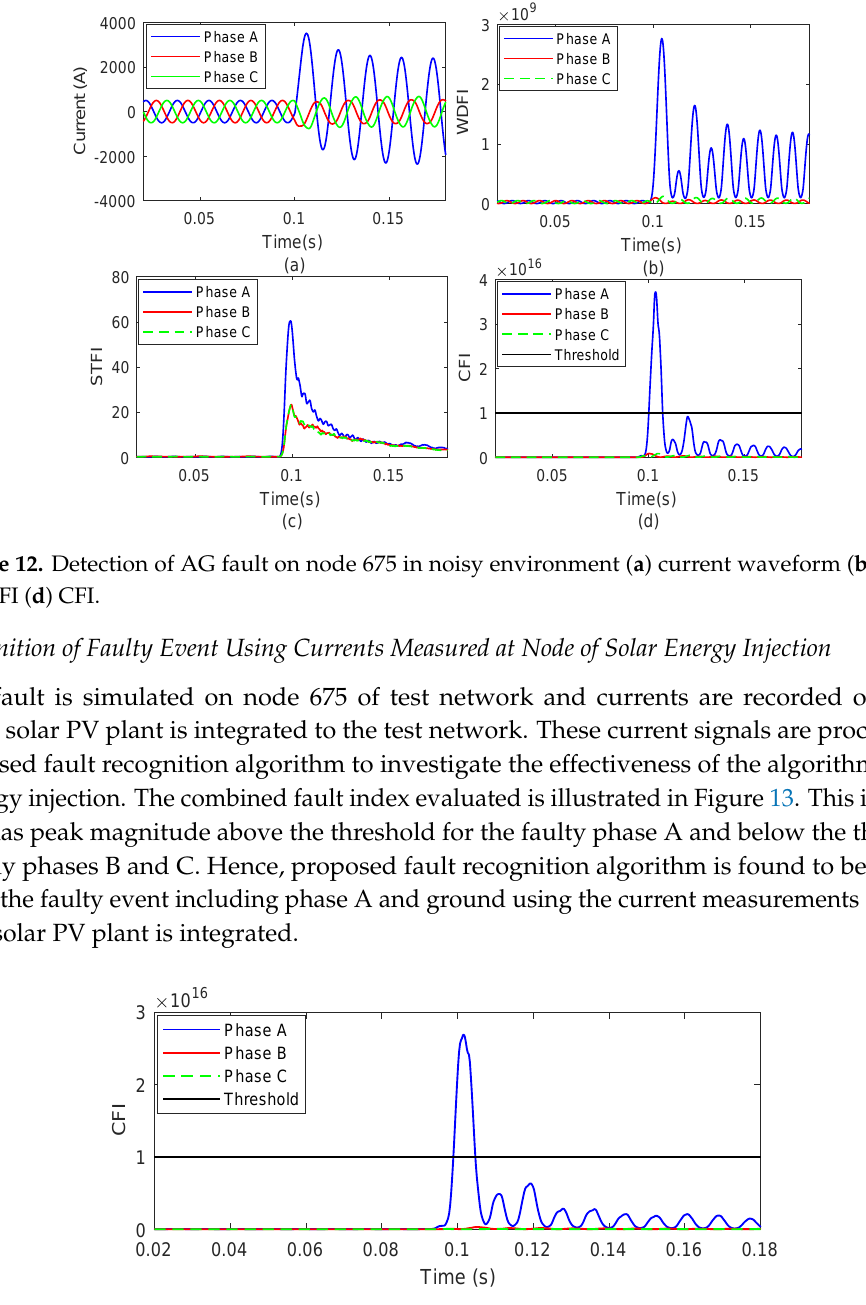
Figure 13. The CFI evaluated by recording currents on node of solar energy injection for detection of AG fault simulated on node